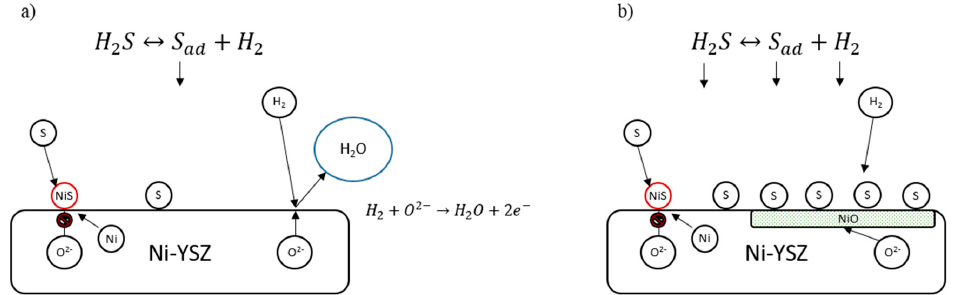
Figure 7. Mechanisms of sulfur poisoning in: ( a ) Low partial pressure of hydrogen sulfide ( P H 2 S) fuel where sulfur adsorption decreases some active sites by forming NiS; and ( b ) High P H 2 S fuel where nickel in the anode oxidizes.